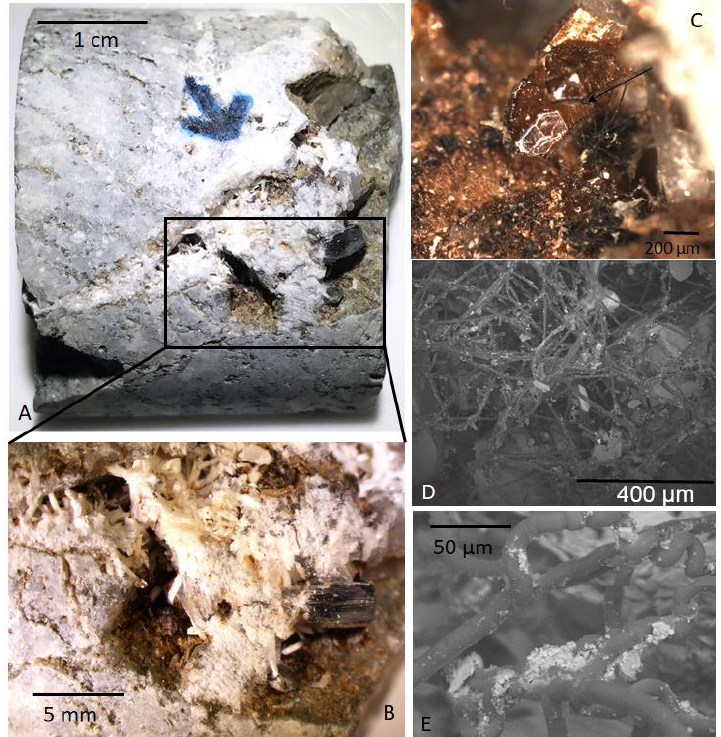
Figure 1. ( A ) Photograph of a piece of drill core from 181.7 meters depth. ( B ) Close up from (A) of a vug containing fossilized mycelia. ( C ) Microphotograph of a calcite covered by a carbonaceous biofilm from which black hyphae is protruding (black arrow). ( D ) Environmental scanning electron microscope (ESEM) image of fungal mycelia. ( E ) ESEM image of branching and coiled